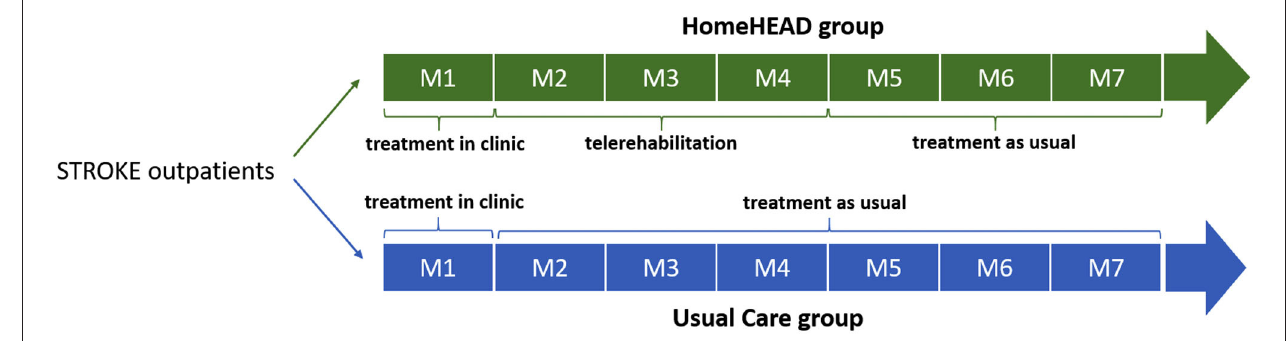
FIGURE 1 | Timeline of the HEAD trial in